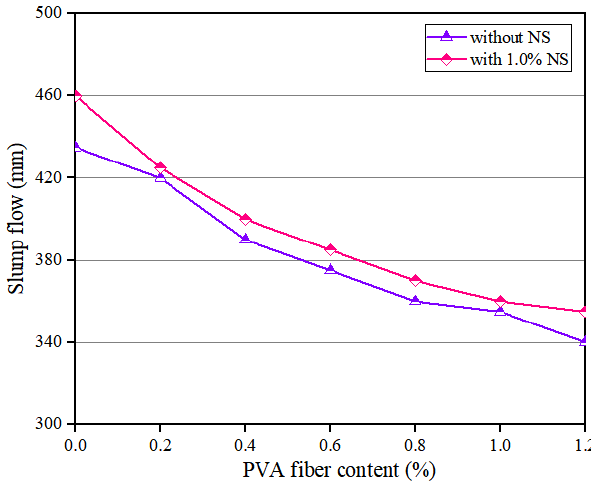
Figure 2. Influence of PVA fiber on flowability of geopolymer composites.